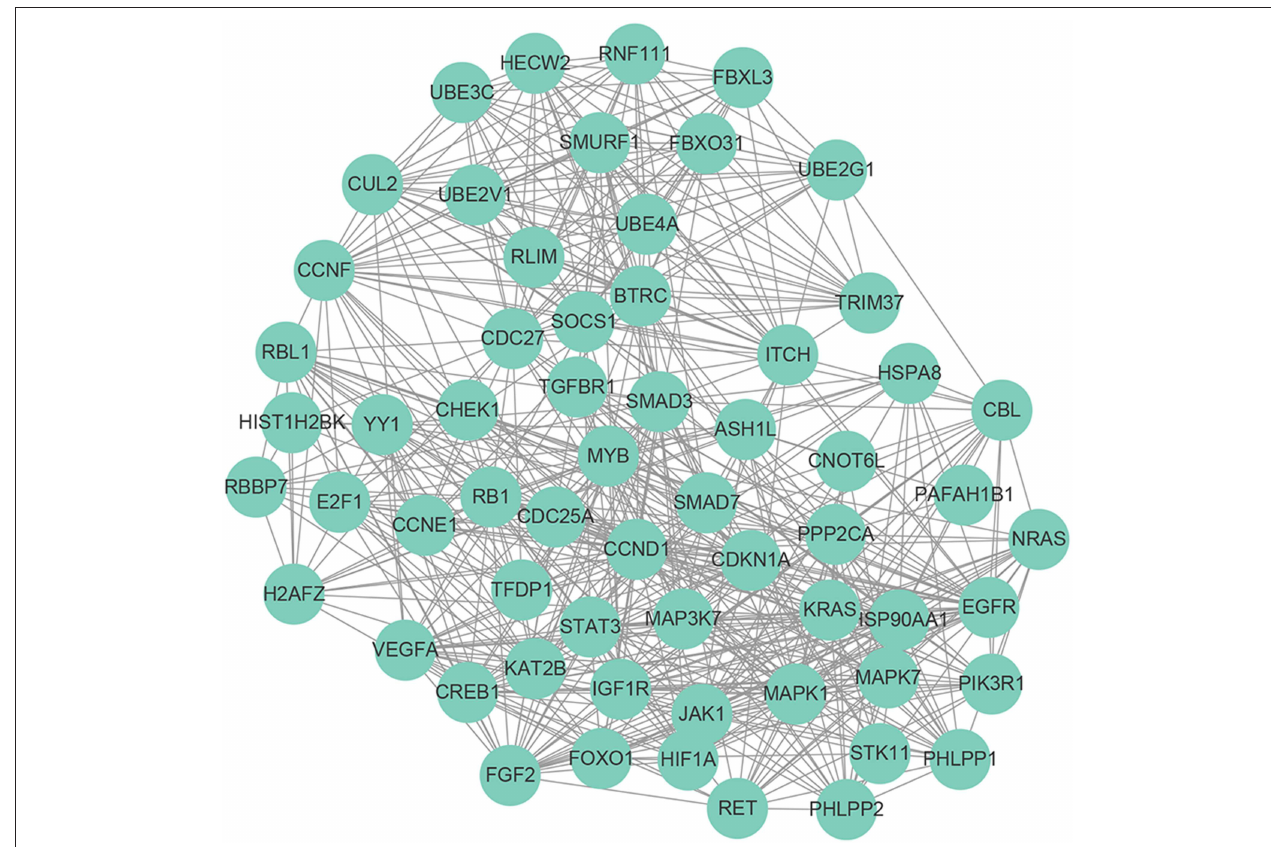
FIGURE 5 | Protein-protein interaction network of the 60 targeted genes interacted with no < 30 other genes.